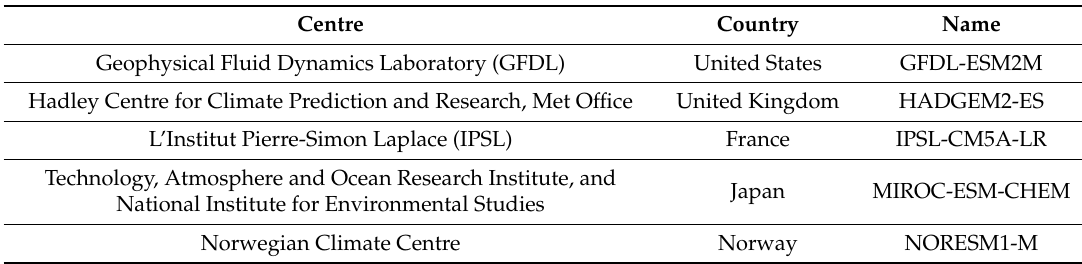
Table 3. Information of selected GCMs.